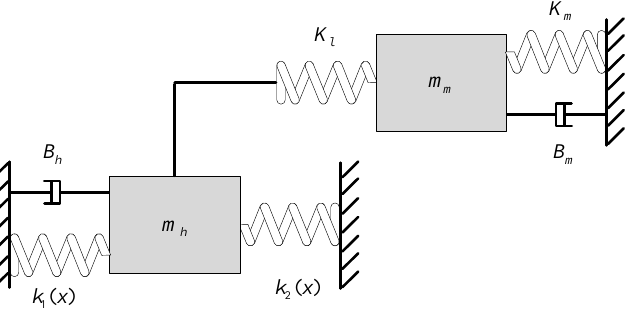
Figure 5. Model diagram of the mechanical – hydraulic coupling spring mass block.